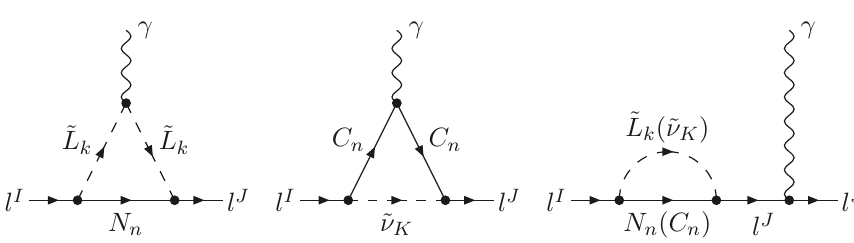
Figure 1 . One-loop supersymmetric contributions to the LF violating e(cid:11)ective lepton-photon interaction (mirror-re(cid:13)ected self-energy diagram not